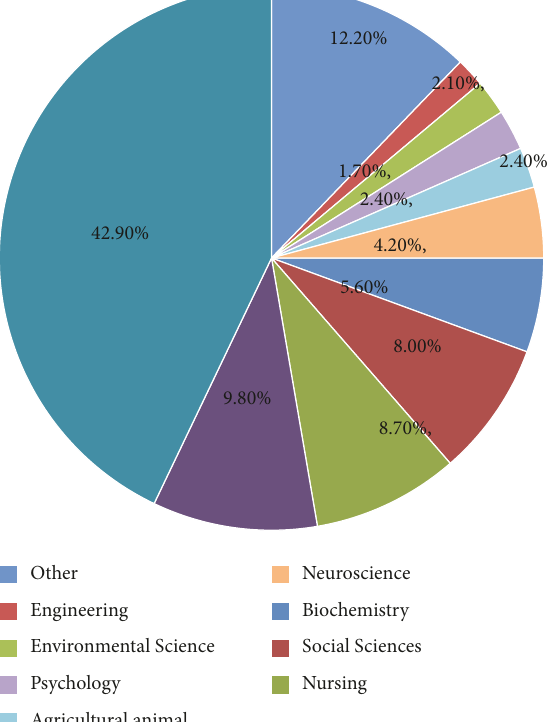
Figure 10: Pie chart depicting article distribution by disciplines for systematic search and review articles.